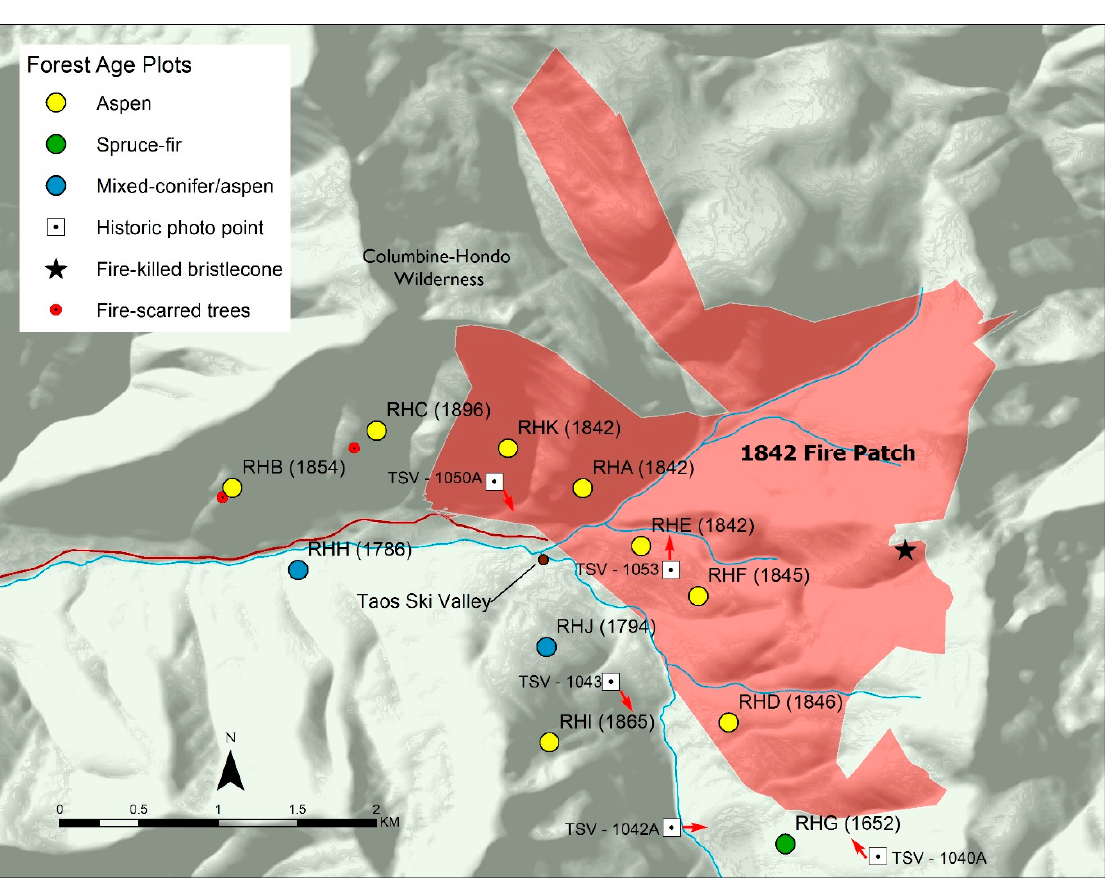
* Plots located within the 1842 high-severity fire patch; † A single aspen cross section cut by R. Pattison from a representative overstory tree.